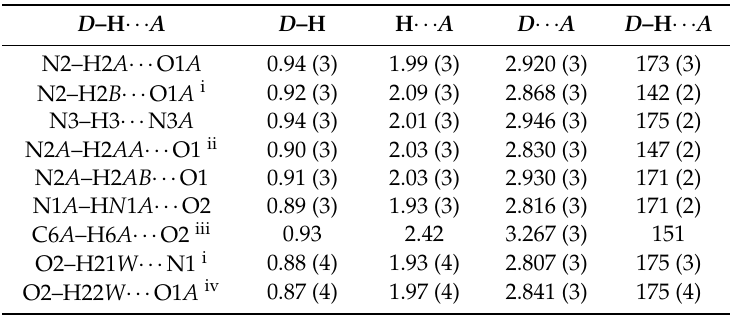
Figure 4. Cluster overlay of PANLAS and (I), showing crystal packing similarity: ( a ) hydrogen-bonded ribbons viewed approximately down b; ( b ) ribbons hydrogen bonded via water molecules viewed approximately parallel to the bc plane. Bonds of molecules of PANLAS have been colored red, bonds of molecules of the title compound are blue. All atoms are shown as small spheres of arbitrary radii. Hydrogen bonding is indicated by orange dashed lines. Table 3. Hydrogen-bond geometry (Å,º) for